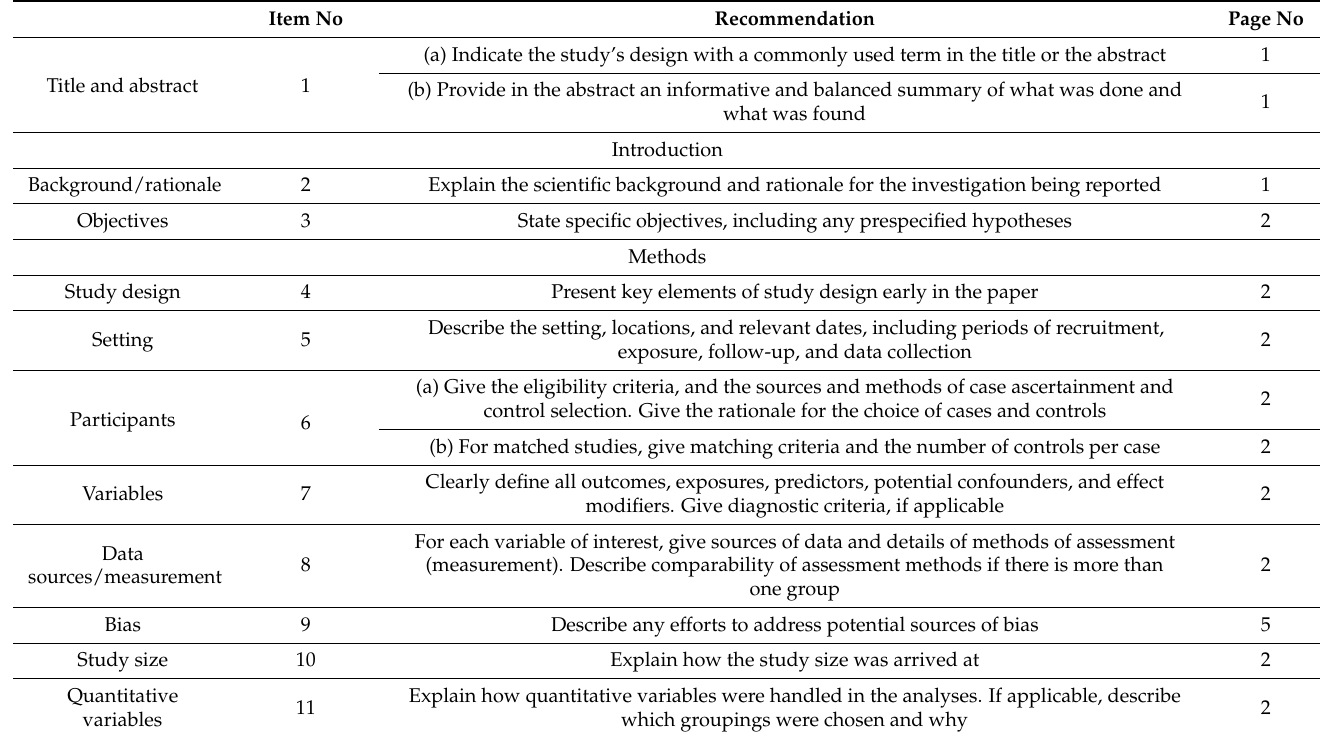
Table A5. STROBE